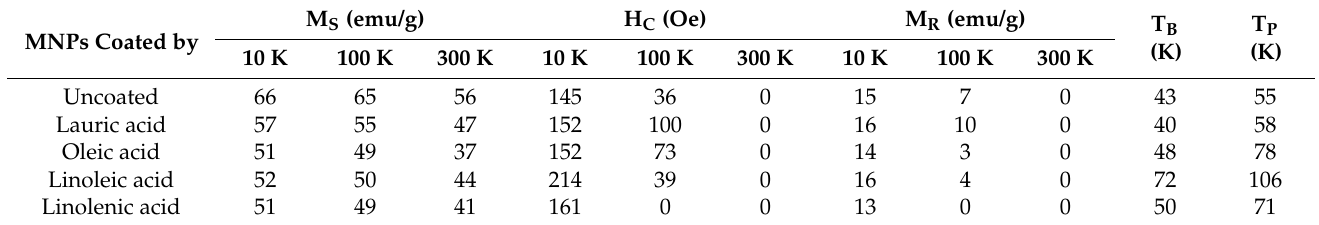
Table 2. Variation of magnetic properties of surfactant hybrids in comparison to uncoated MNP.